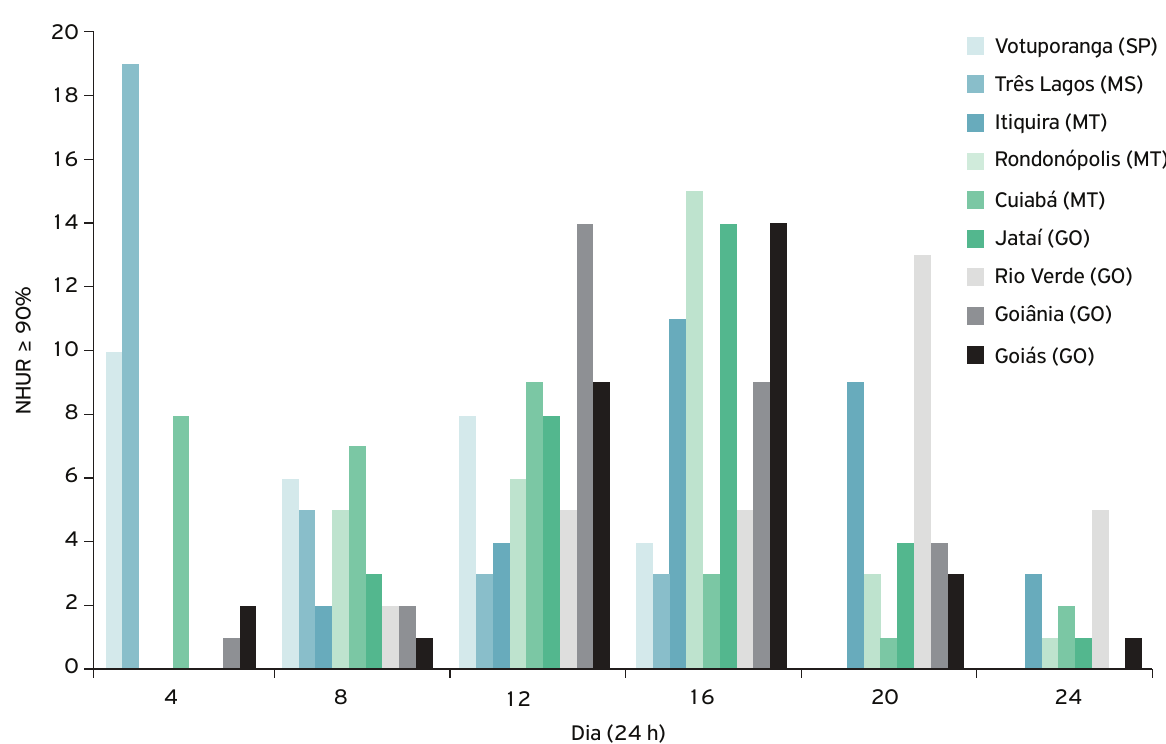
Figura 3. Distribuição da frequência diária do número de horas de umidade relativa do ar igual ou maior que 90%, no período entre 12 de janeiro e 10 de fevereiro de